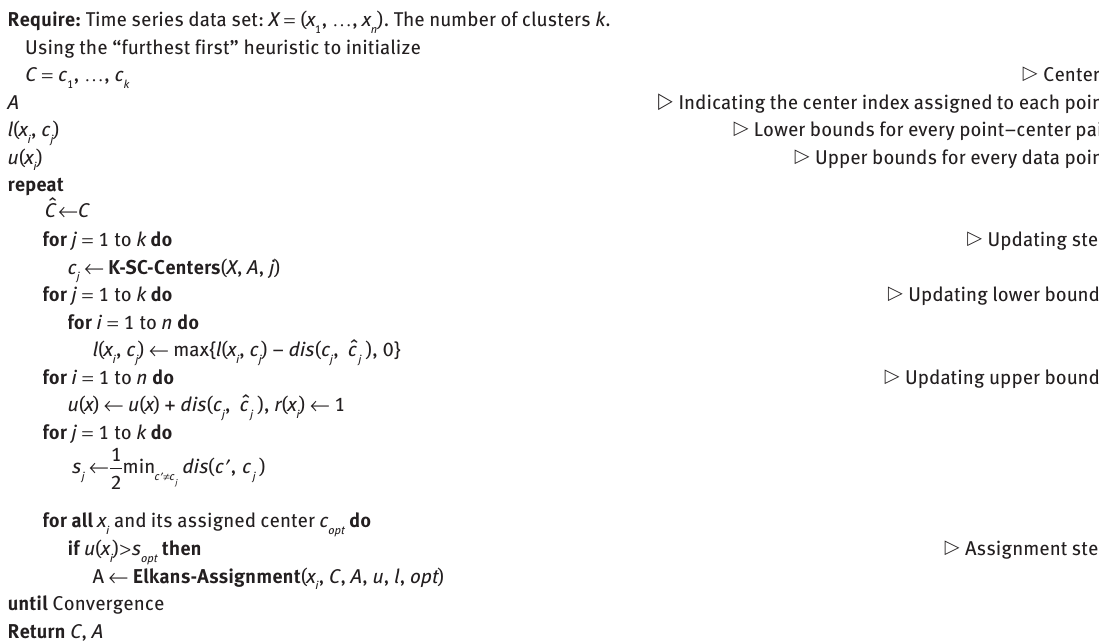
Algorithm 1. Accelerated K-SC Clustering